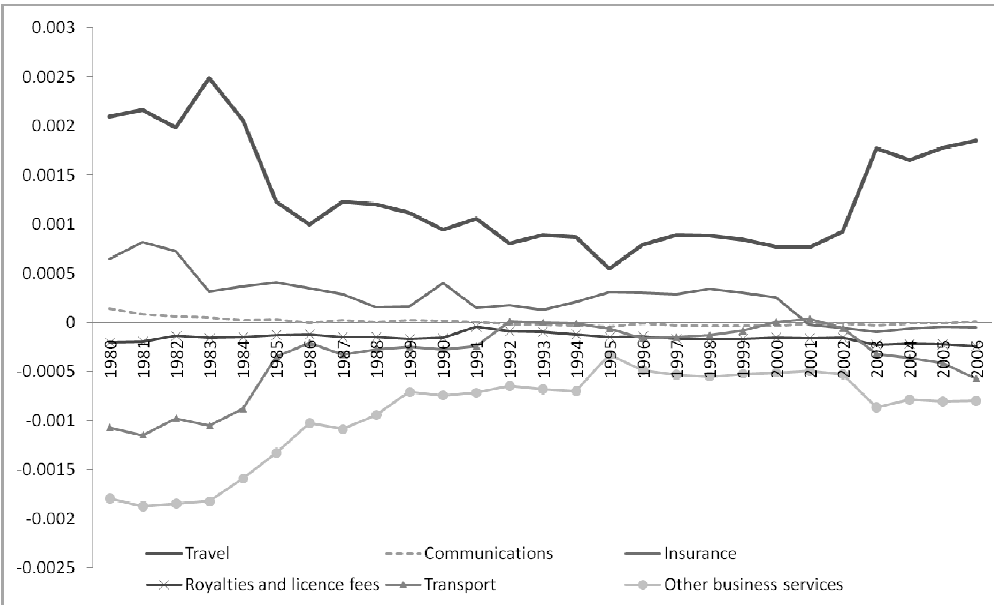
evealed Symmetric Comparative Advantage of service exports, South Africa,